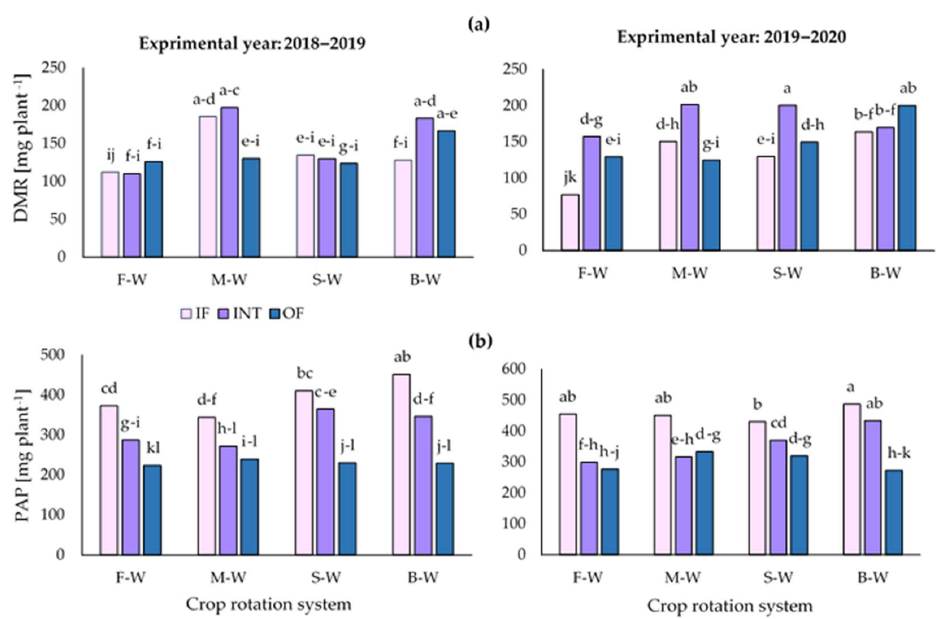
Figure 4. Effects of interactions between three farm management practices (intensive, IF; organic, OF; and integrated, INT) and four crop rotation systems (fallow-wheat, F-W; maize-wheat, M-W; sesame-wheat, S-W; and mung bean-wheat, B-W) on ( a ) dry matter remobilisation (DMR), and ( b ) post-anthesis dry matter photosynthesis (PAP) during the two-year experiment. Means were compared by Duncan’s test, and different letters above each bar indicate a significant difference at p ≤ 0.05. Table 3. Effects of year (Y), farm management practice (F), crop rotation system (CS), and their interactions on the yield, yield components, and grain protein content in winter wheat during the period of 2018–2020, as determined by ANOVA.